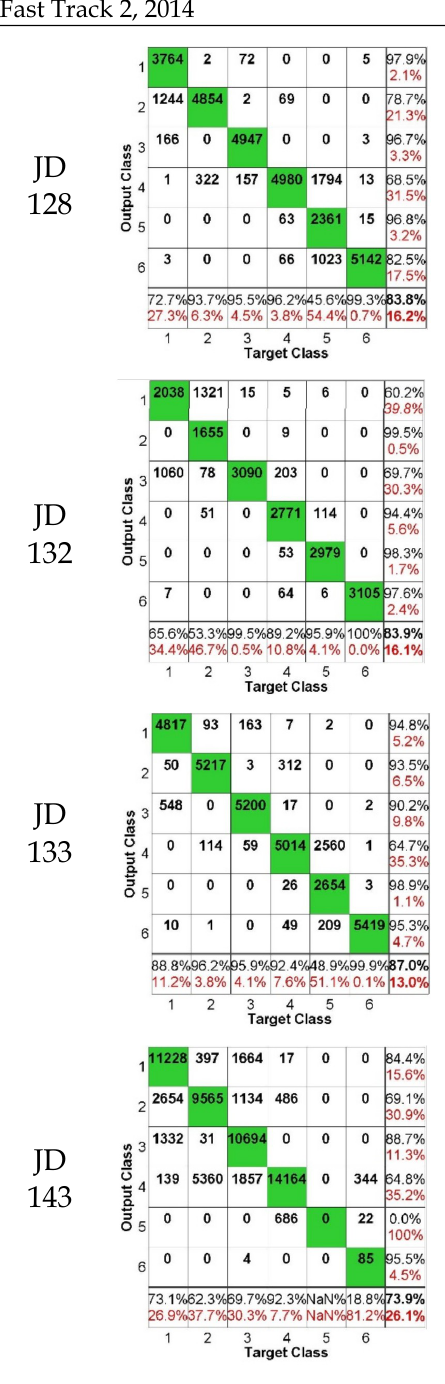
Figure 3: Confusion matrices. The six classes are: 1 – Ash above Sea. 2 - Ash above meteorological clouds. 3 – Meteorological clouds. 4 – Sea. 5 – Ice. 6 –